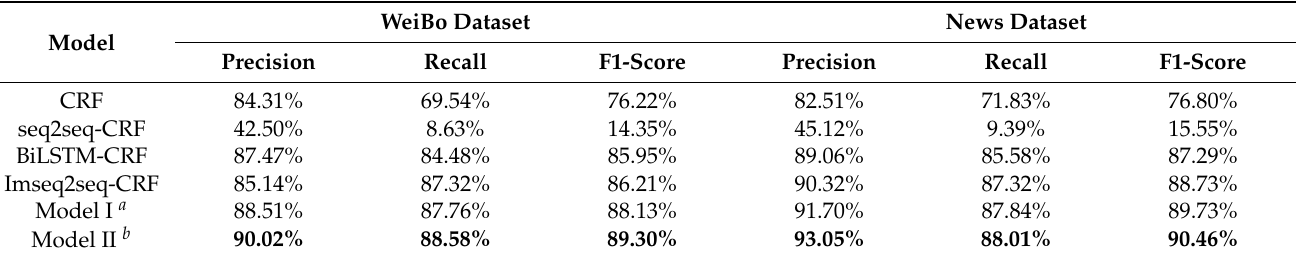
Table 3. Identification results of the third party dataset.